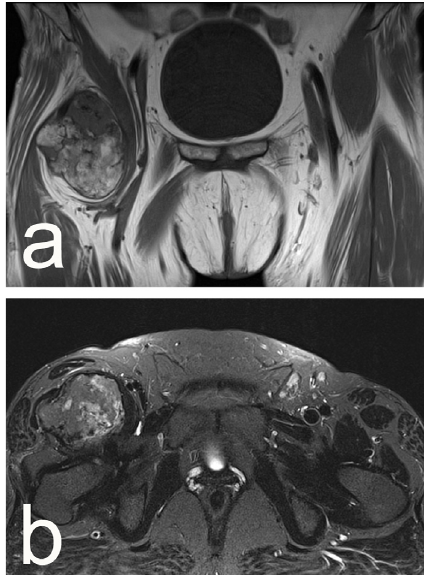
Figure 2. (a, b) Preoperative MRT showed a well-circumscribed ovoid radiopaque mass confined to the iliopsoas muscle belly.